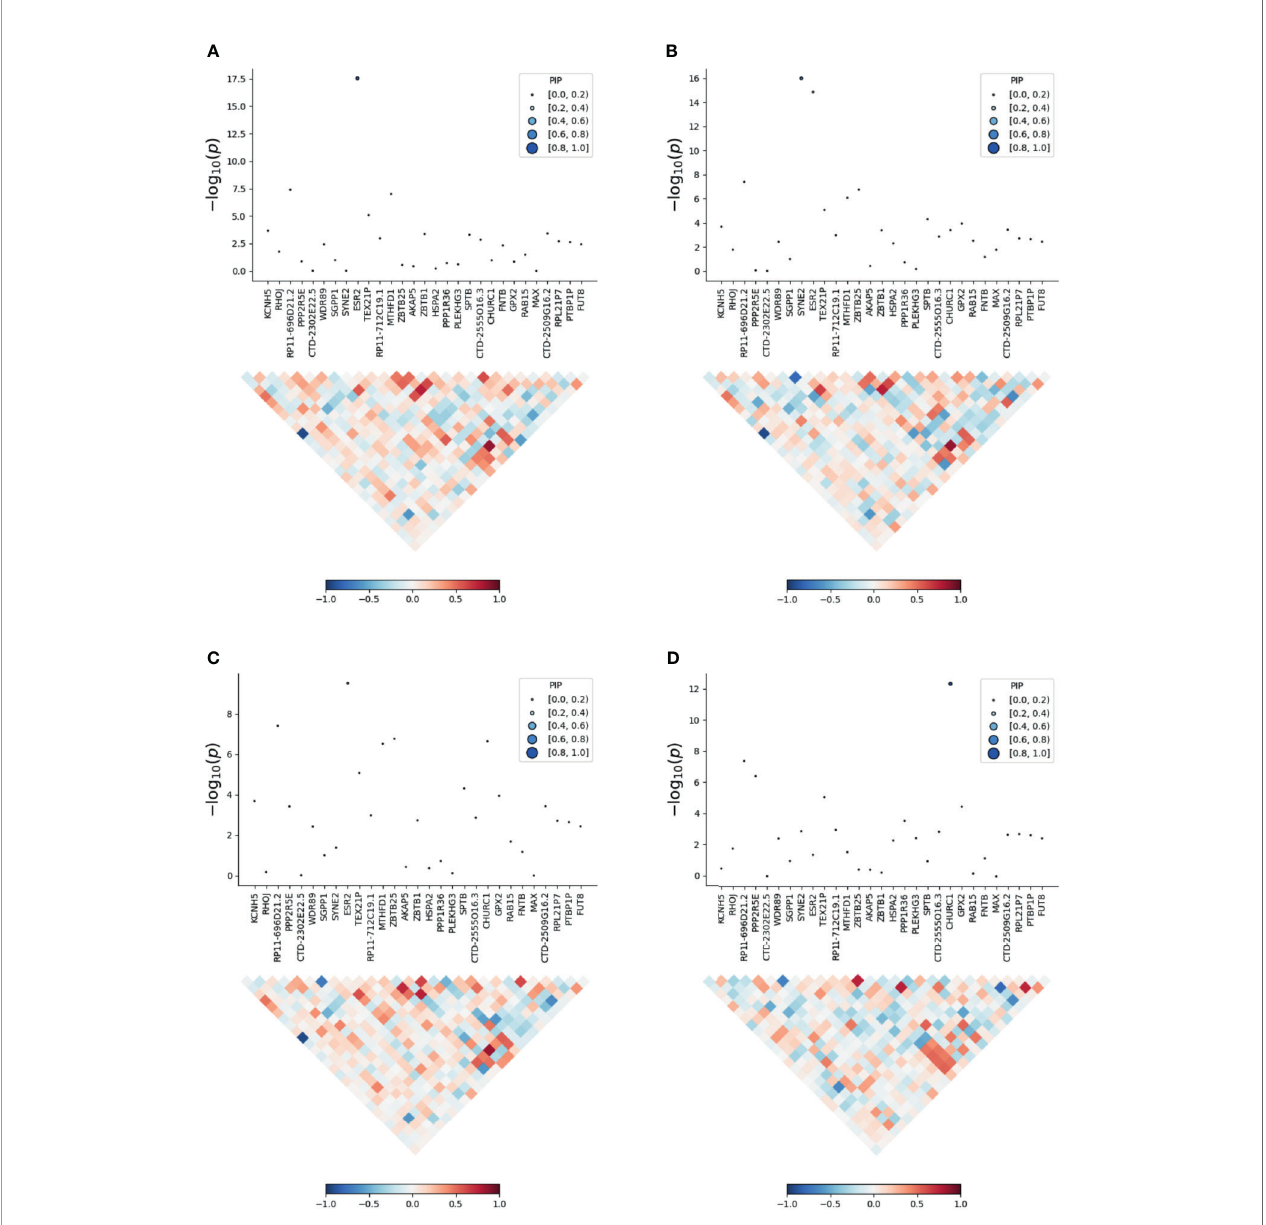
FIGURE 3 | Transcriptome-wide association study of the meta-analysis of MDD and ADs. (A) skin; (B) blood; (C) lung; (D) brain. Within each panel, the top part is the transcriptome-wide association signal indicating strength of the predicted expression association with trait, and the bottom part is the induced correlation of the predicted